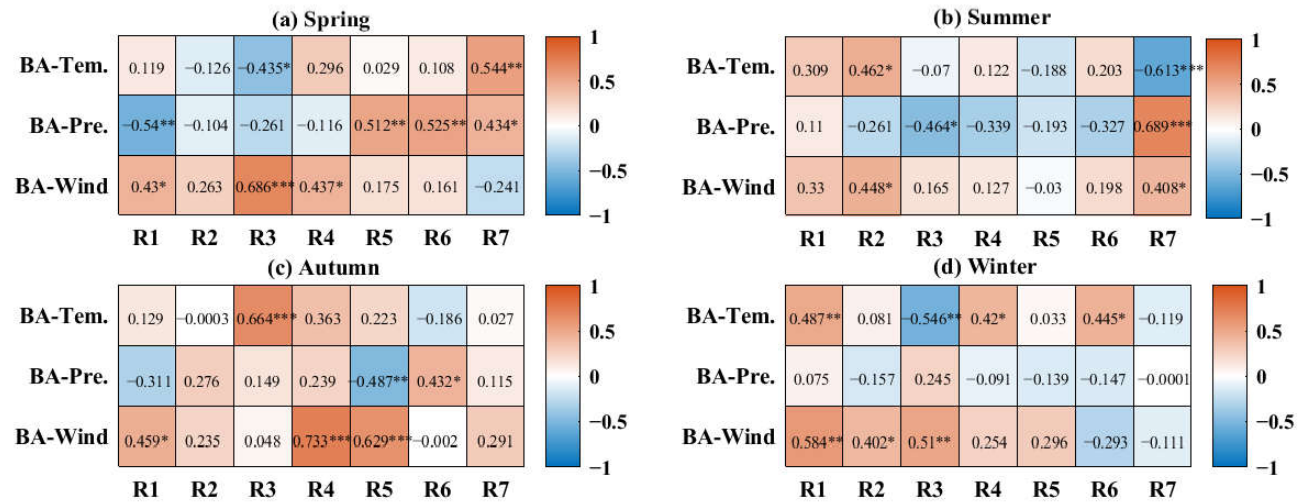
Figure 15. Correlation coefficients between BA and three climatic factors in seven subregions in four seasons: ( a ) spring; ( b ) summer; ( c ) autumn and ( d ) winter. * indicates passing the signifi-